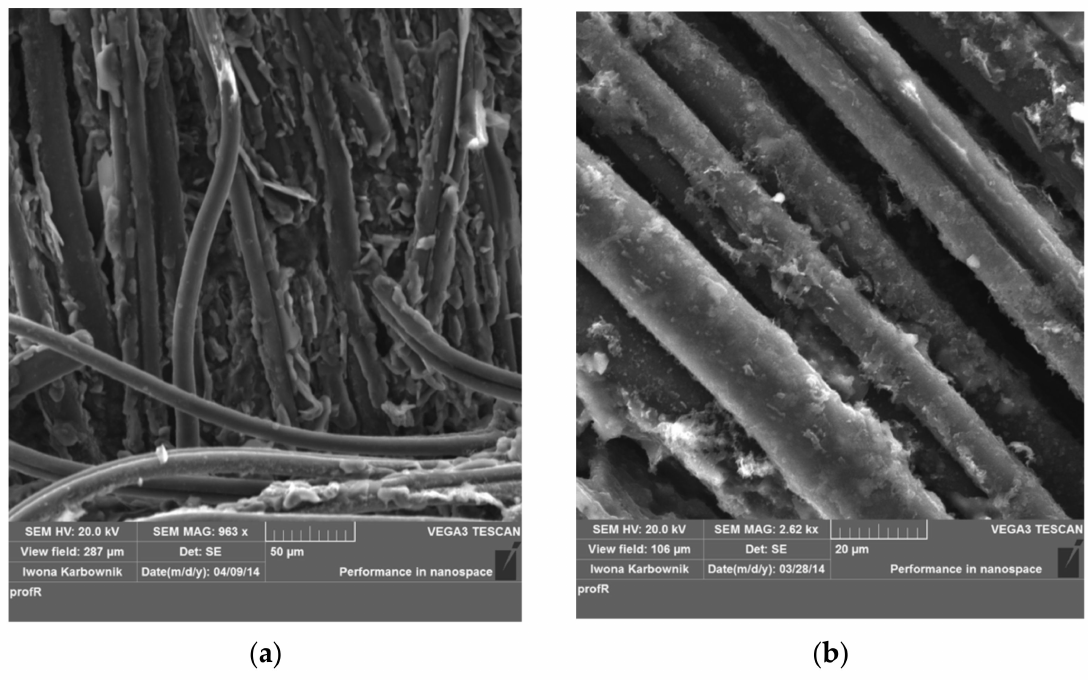
Figure 5. SEM images of: ( a ) Three layers of PANI; ( b ) three layers of PPy inkjet printed on PAN